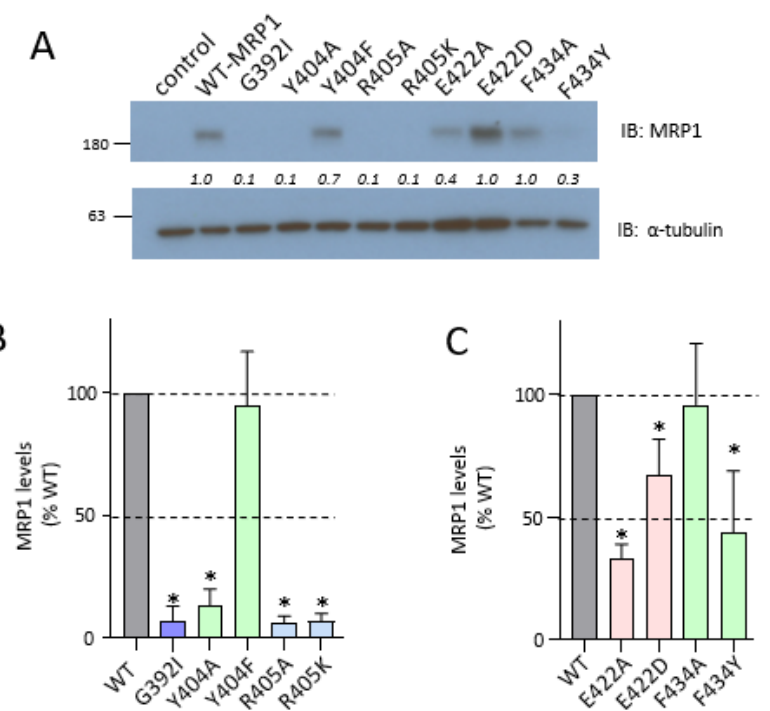
Figure 4. Effect of mutating residues outside the CL4 coupling helix on hMRP1 protein expression levels in HEK cells. Wild-type and mutant hMRP1 expression levels were measured by immunoblot- ting of WCE prepared from transfected HEK cells. Blots were probed with anti-hMRP1 (Mab QCRL-1) and anti- α -tubulin as a protein loading control. ( A ) Representative immunoblot of WCE (10 µ g per lane) prepared from all upstream (G392I, Y404A, Y404F, R405A, R405K) and downstream (E422A, E422D, F434A, F434Y) mutants. Relative levels of wild-type (WT) and mutant hMRP1 were estimated using densitometry, and values were normalized according to the α -tubulin signal (shown in italics). The region between the hMRP1 and the α -tubulin signals has been cropped out; molecular weight markers (kDa) are indicated on the left of the blot. ( B , C ) Quantitation of mutant hMRP1 levels, with each bar representing the mean ( ± SD) of results obtained from 3–5 independent transfections and expressed as a percent of wild-type (WT) hMRP1 levels: ( B ) upstream mutants (G392I, Y404A, Y404F, R405A, R405K); ( C ) downstream mutants (E422A, E422D, F434A, F434Y). * Significantly different from wild-type hMRP1 ( p < 0.05).